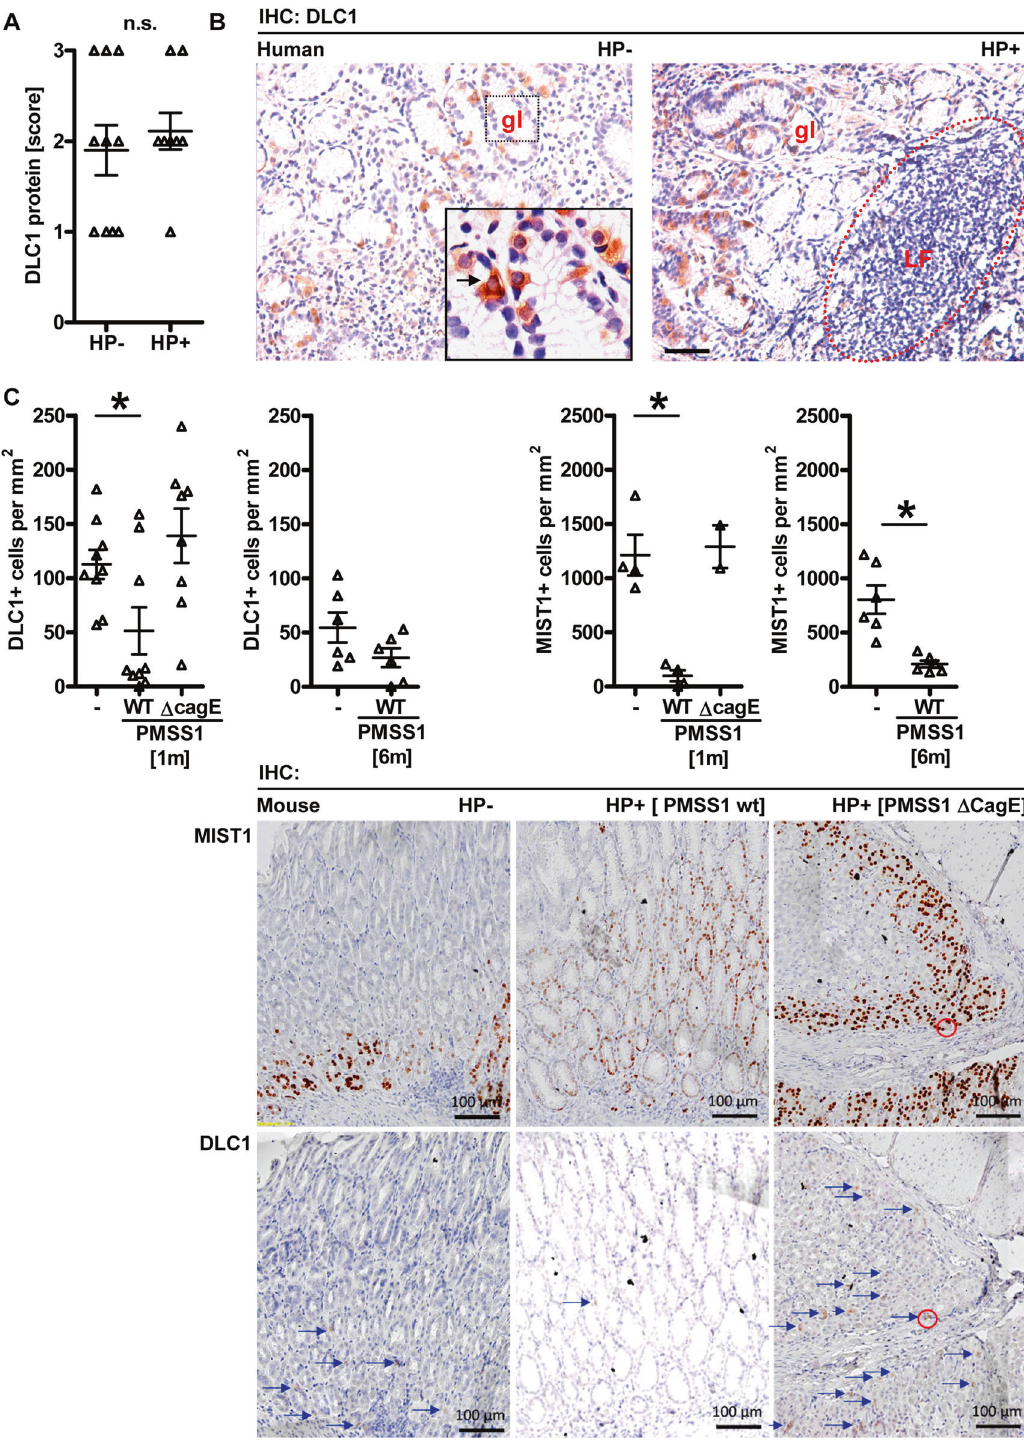
Fig. 2 Helicobacter pylori infection downregulates DLC1 expression in vivo. A DLC1 positivity in uninfected and H. pylori -infected human gastric biopsies. Sections from FFPE human stomach tissue ( n = 9 Hp + vs. n = 10 Hp- cases) from endoscopic material were stained with DLC1 Ab by IHC. Positivity scores for DLC1 were correlated to the infection status. Data are absolute case numbers after dichotomous grouping of stainings as negative ( scores 0/1 ) vs. positive ( scores 2/3 ) (n.s., Hp + vs. Hp-, Fisher-Exact test). B H. pylori -induced in fl ammatory cell in fi ltrates outcompete DLC1 + cells in human gastric biopsies. Representative IHC images from ( A ) of the corpus region (left, healthy; right, gastritis). Colour code: Brown = DLC1; Blue = nuclei (hematoxylin). Original magni fi cations ×200; Scale bar = 50µm. Note the displacement of DLC1 + cells by accumulating intramucosal leucocytes in in fl ammatory regions. C H. pylori downregulates DLC1 + positivity in vivo. C57BL/6J mice were infected with mouse- adapted CagA + injection-pro fi cient H. pylori PMSS1 WT strain or CagA-injection-de fi cient isogenic mutant Δ CagE for 1 or 6 months. Sections from FFPE gastric tissue were stained with Abs against chief/stem cell marker MIST1 or DLC1. Quantitative analyses (top) and representative IHC images of the corpus region (bottom). Data are cell numbers per mm 2 (* p < 0.05 vs. WT, Kruskal – Wallis test with Dunn or Sidak post-tests, n = 2 – 9 mice per group or time point). Colour code: Brown = DLC1/MIST1; Blue = nuclei (hematoxylin). Original magni fi cations ×100; Scale bar = 100 µm. Cell Death Discovery (2022)